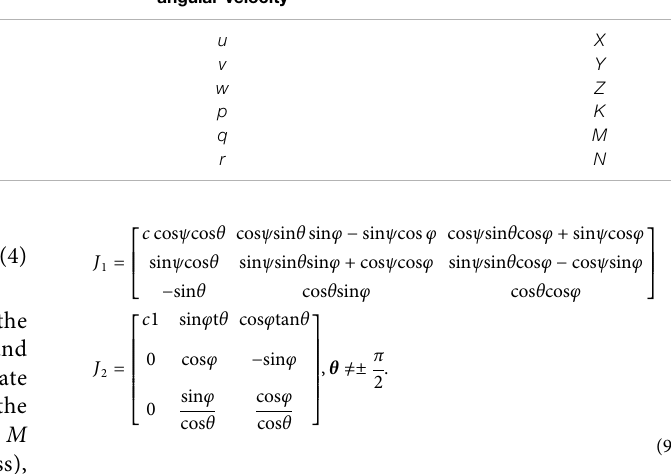
and Euler angle